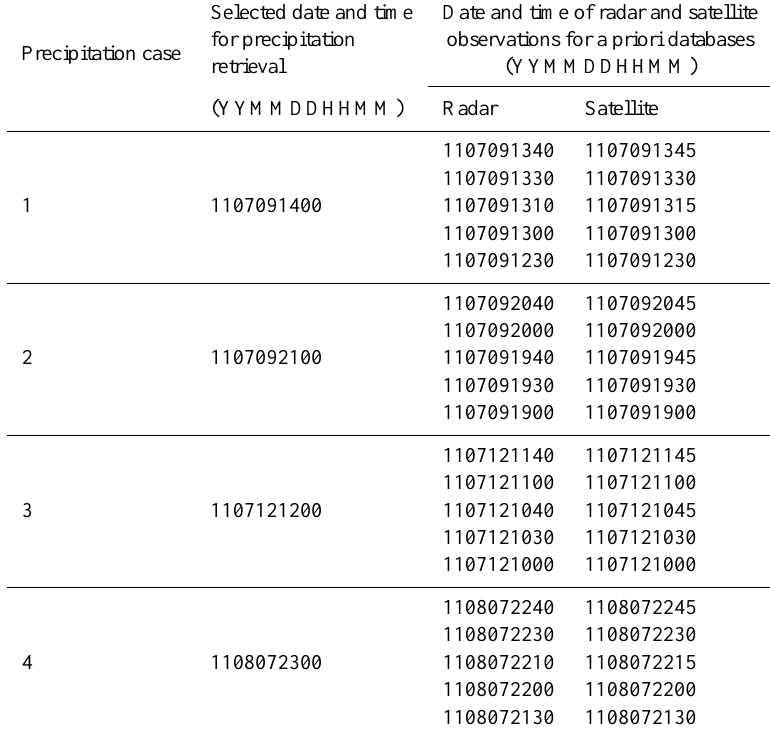
Table 1. List of precipitation cases for the precipitation estimations from the geostationary satellite and construction of a priori databases. Selected date and time Date and time of radar and satellite for precipitation observations for a priori databases Precipitation case retrieval (YYMMDDHHMM) (YYMMDDHHMM) Radar Satellite 1107091340 1107091345 1107091330 1107091330 1 1107091400